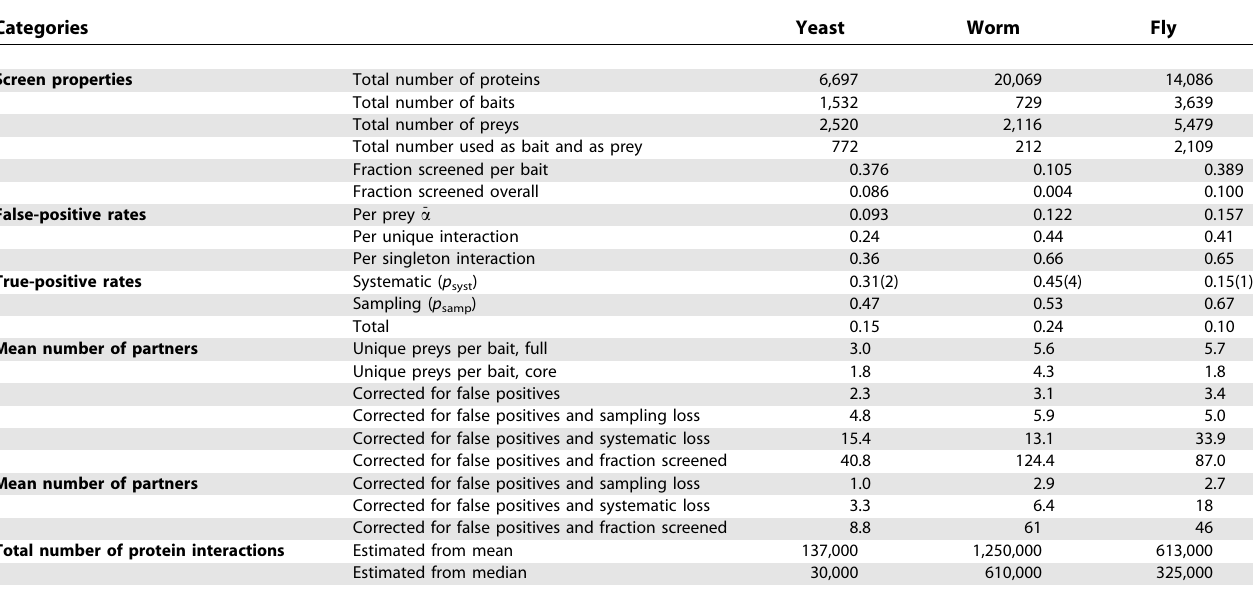
Table 3. Error Rates and Projections for Full Coverage Provided for Yeast (PL-MIXTURE), Worm (TPL-MIXTURE), and Fly